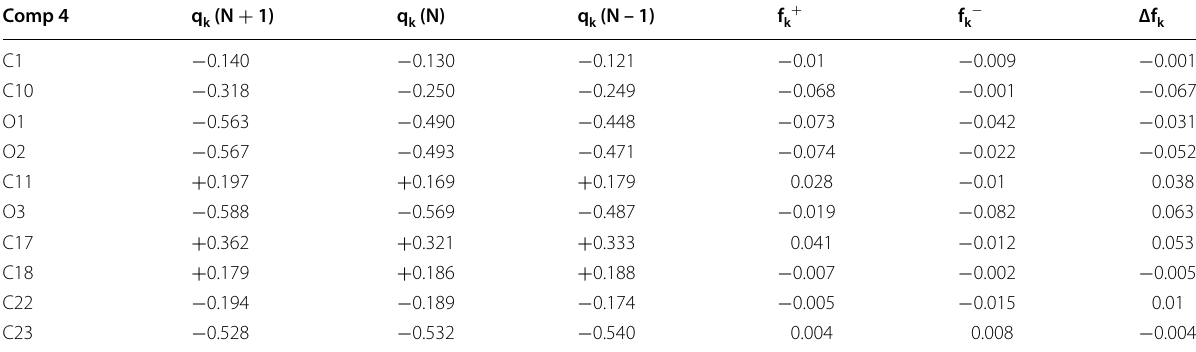
Table 5 Selected Mulliken atomic charges and Fukui functions for Compound 4 Comp 4